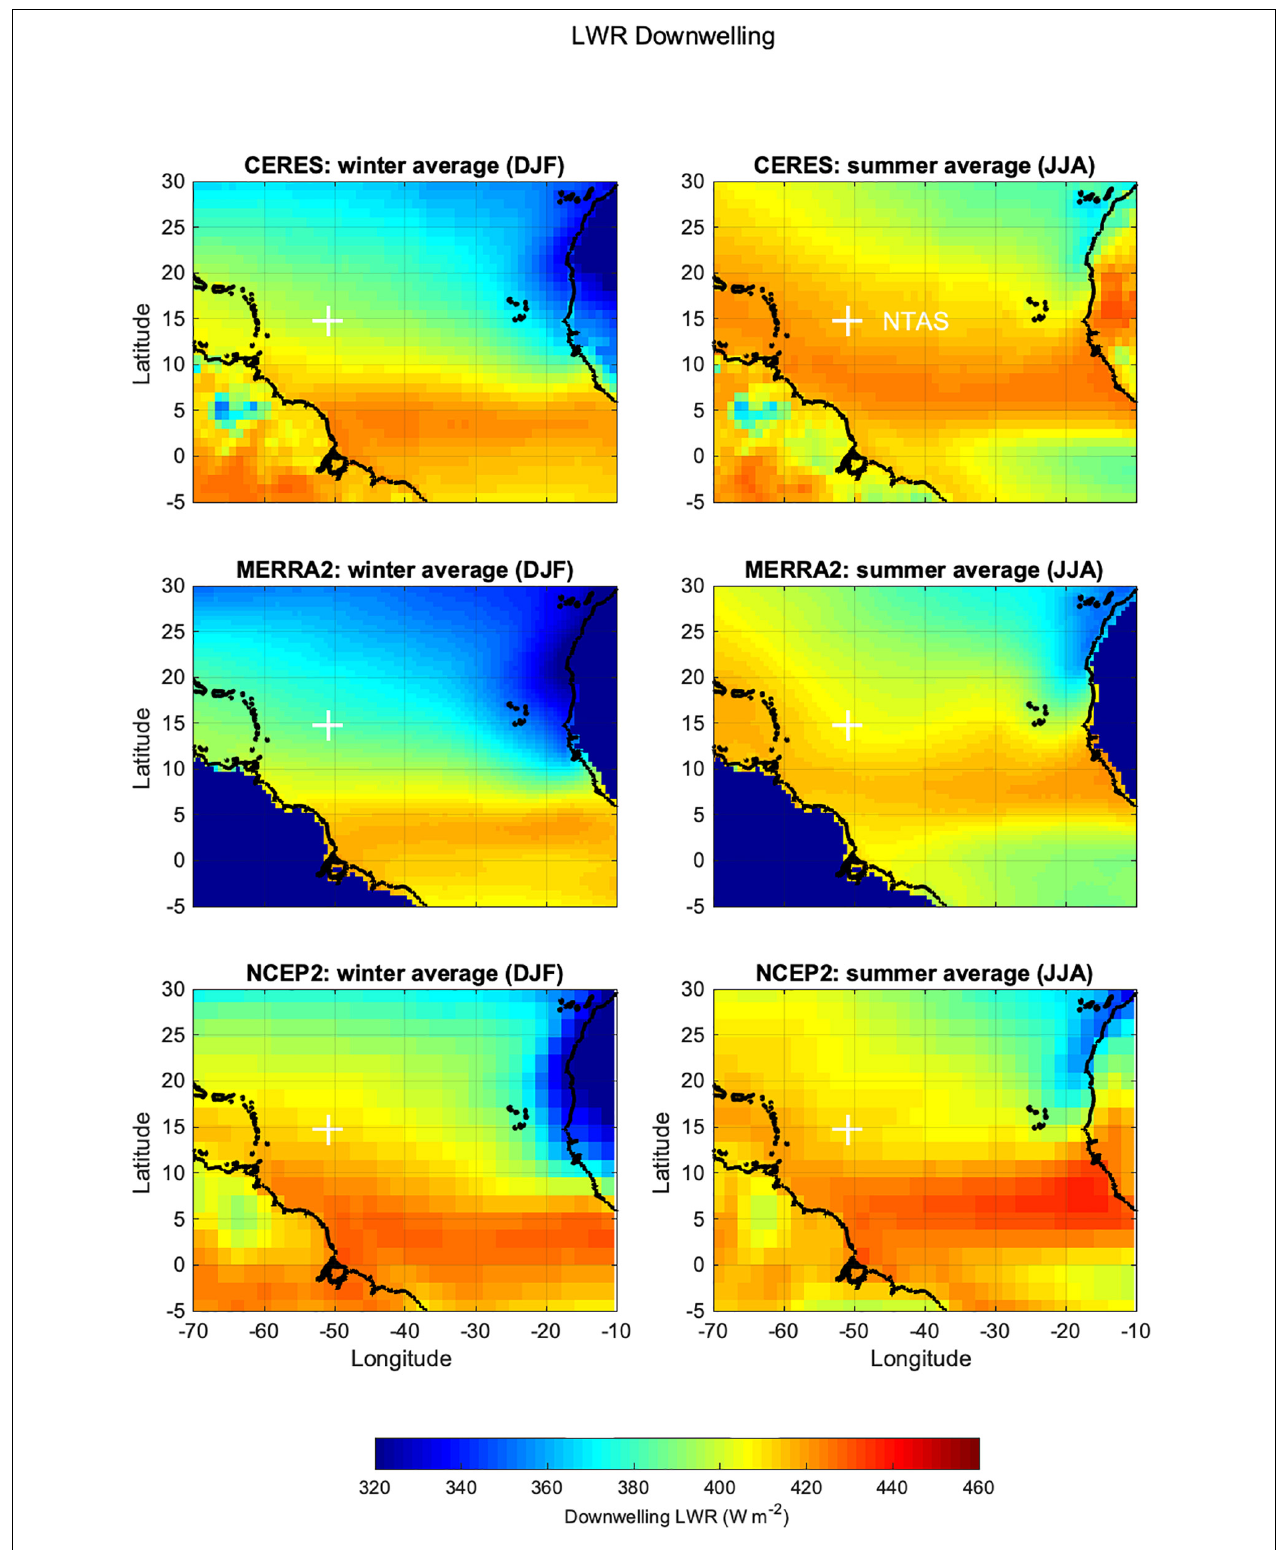
FIGURE 5 | Maps of seasonal climatology from years 2002 to 2011 in the tropical Atlantic: net downward longwave radiation flux at the surface (in W m − 2 ), during boreal winter months (left) and summer (right). CERES (top row), MERRA-2 (middle row) and NCEP-2 (bottom row).